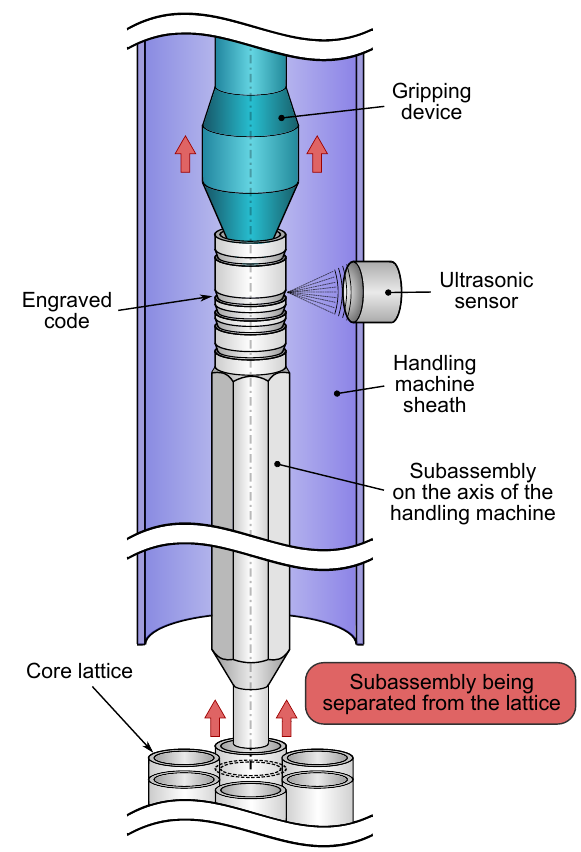
Fig. 1. Schematic diagram of a favorable reading configuration for which the sub-assembly is high enough to be completely free from the